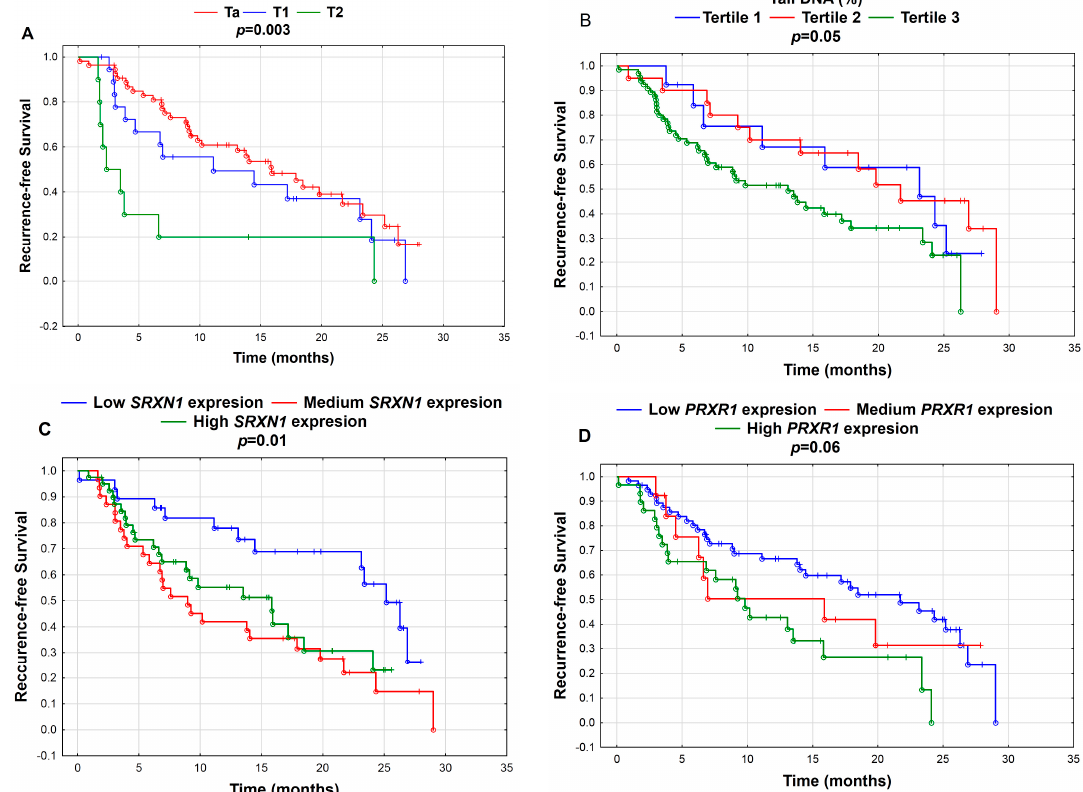
Figure 1. Kaplan–Meier curves for recurrence-free survival according to ( A ) tumor stage (Ta, T1, T2); ( B ) tertiles of tail DNA (%)—Tertile 1 ( ≤ 3.74% Tail DNA; N = 7), Tertile 2 (3.75–5.11% Tail